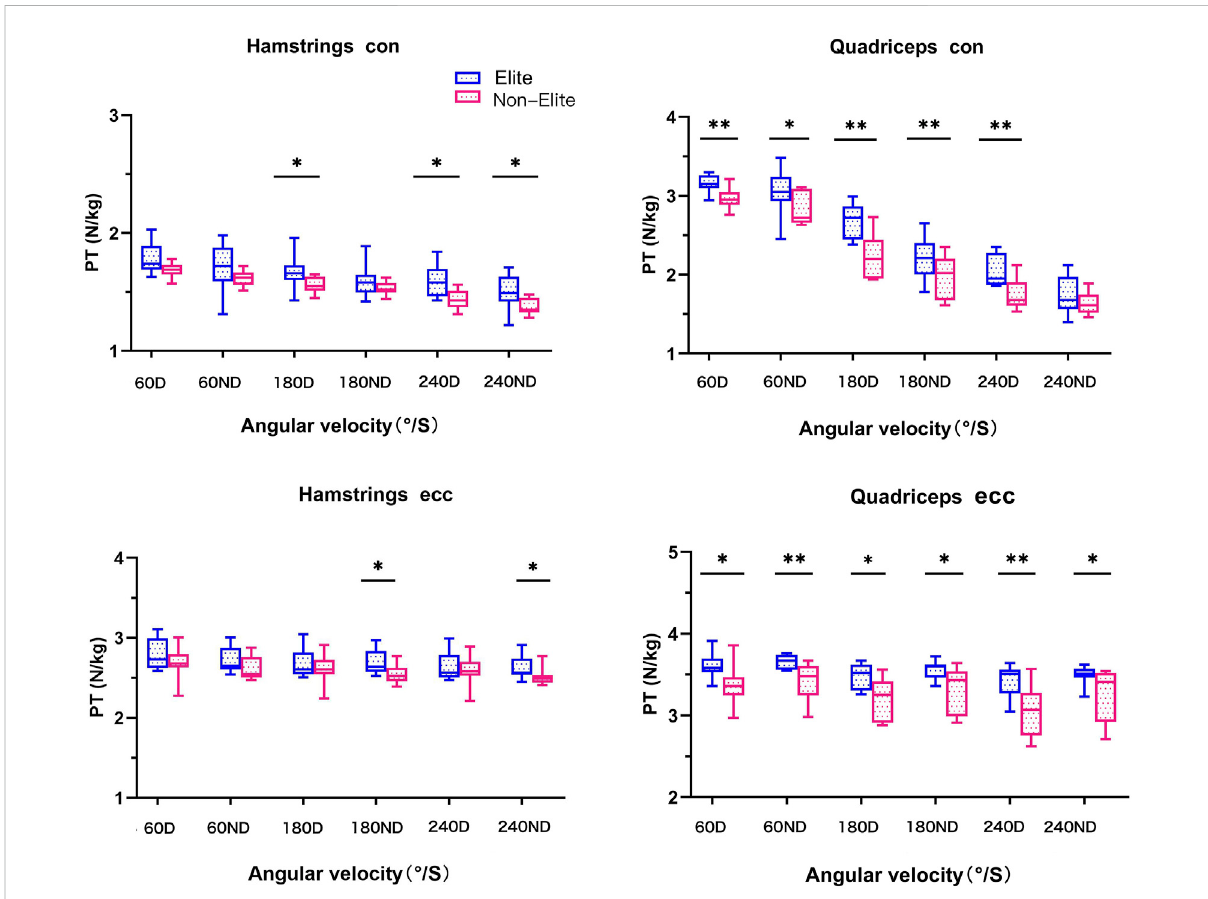
FIGURE 2 Relative peak torque (RPT) of hamstring (H) and quadriceps (Q) of the knee against 60 ° /S, 180 ° /S, and 240 ° /S in boxers. Con, concentric; ecc, eccentric; D, dominant limb; ND, non-dominant limb; differences between the elite and non-elite group were presented as * p < 0.05, ** p <